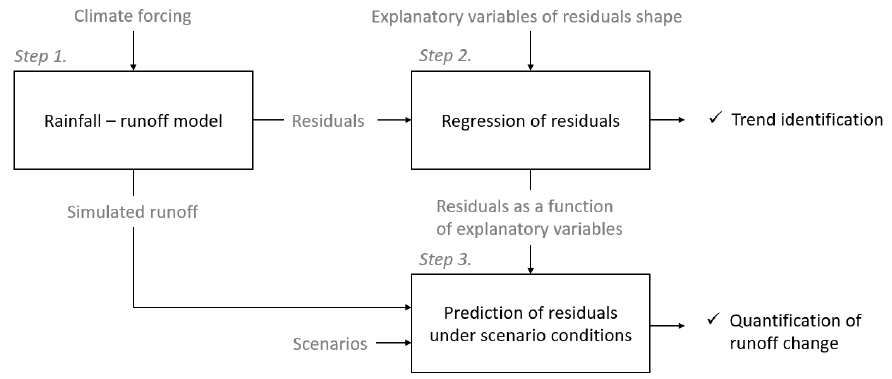
Figure 4. Shematic representation of the steps used to indentify the origin of trends and quantify the runoff